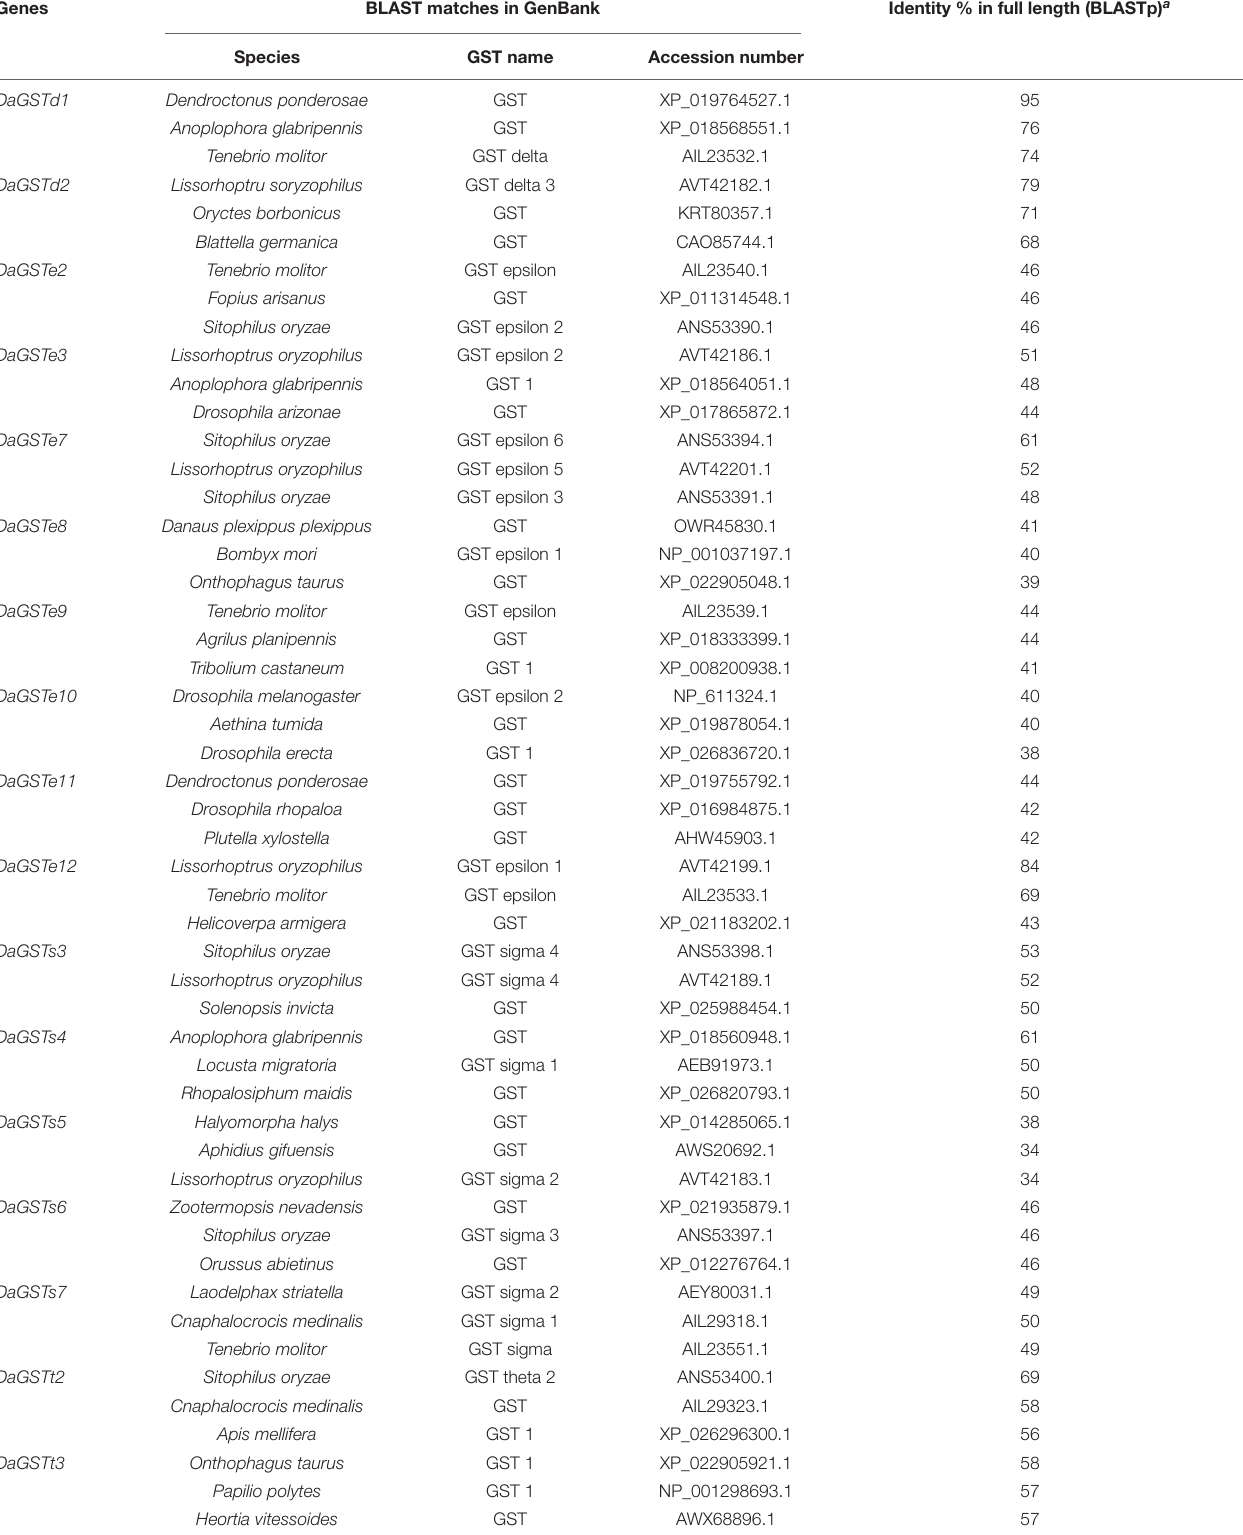
TABLE 2 | Putative amino acid identity of GST cDNA isolated from Dendroctonus armandi and GST sequences from other species. Genes BLAST matches in GenBank Identity % in full length (BLASTp) a